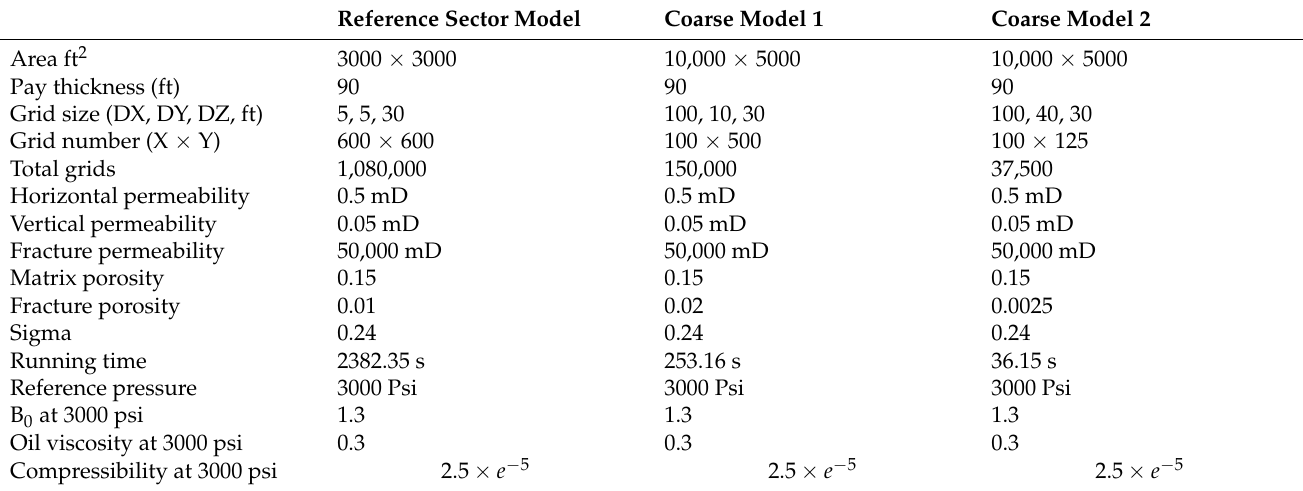
Table 1. Reservoir rock and fluid properties of a reference sector model and coarse grid models.